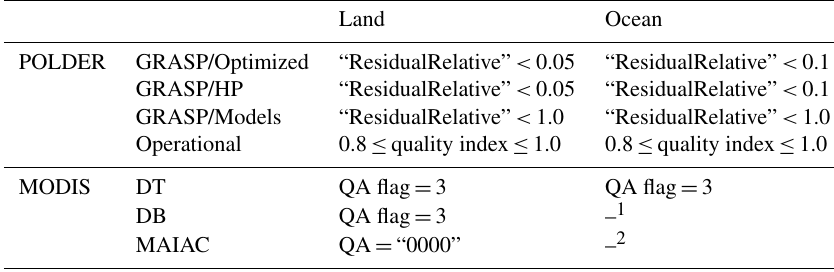
Table 2. Strategies used to select quality-assured PARASOL and MODIS aerosol products.